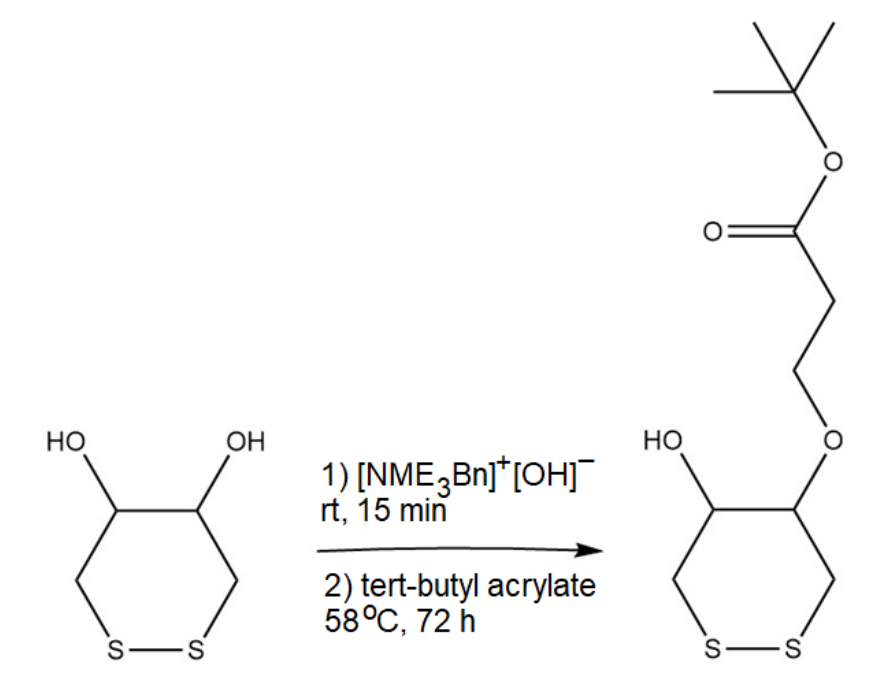
Figure 4. Conversion of oxidized DTT to tert-butyl 3-(DTT)propanoate. During the reaction, the product was monitored with thin layer chromatography using 3:1 v/v hexane/ethyl acetate eluent (Figure 5). The reaction was stopped at the appearance of the hydrophobic products (C spots) which may contain the compound with both hydroxyl groups modified to tert-butyl propanoate. The C spots were removed with the subsequent flash chromatography and the desired product, TBu-Ox-DTT (B spot), was purified. Ox-DTT (A spot) was also saved for repeating the